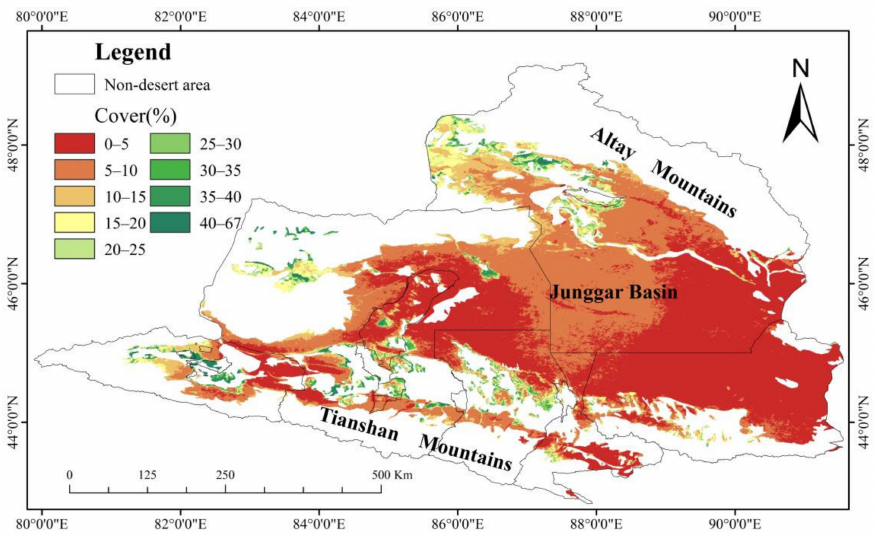
Figure 4. Spatial distribution of the average yearly maximum vegetation coverage in the Junggar Basin from 2000 to